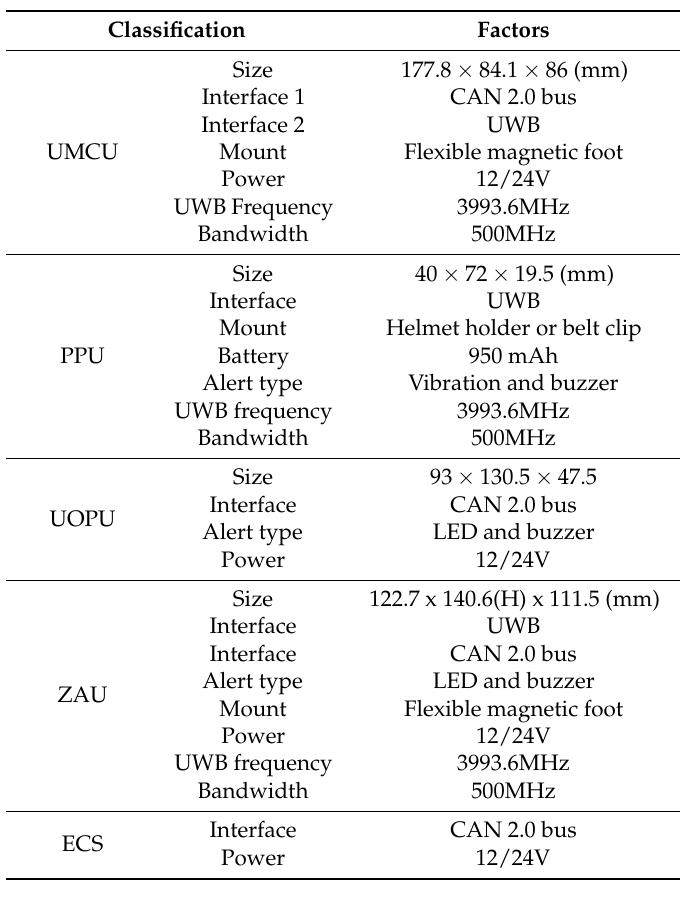
Table 5. Specifications of UMCU, PPU, UOPU, ZAU, ECS, and